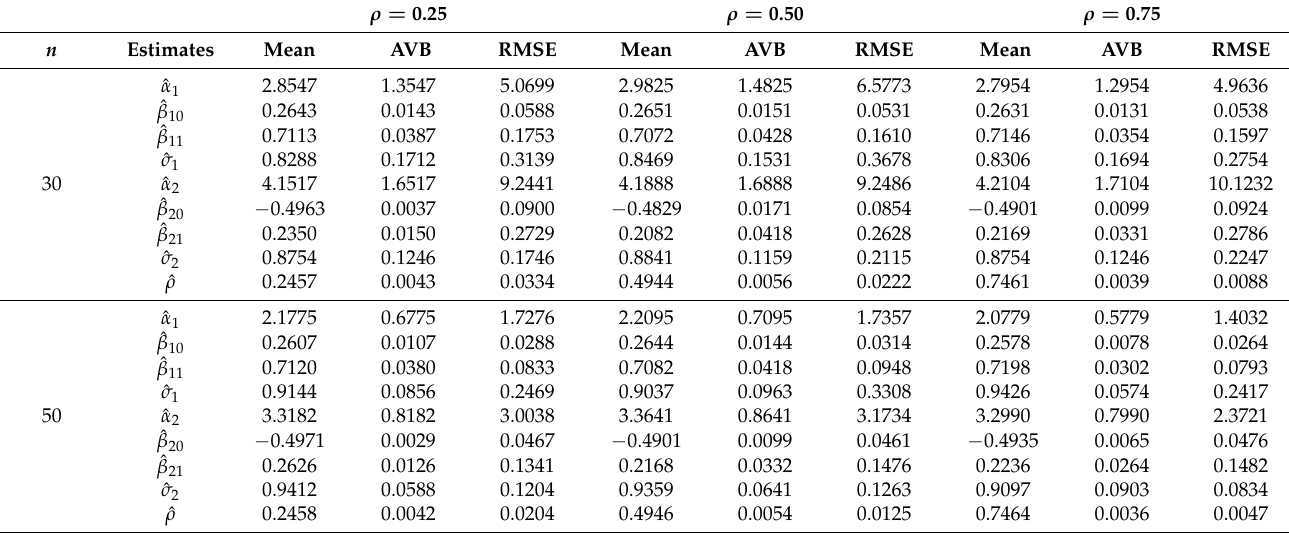
Table A1. Asymptotic behavior of the MLE for the BVSHN regression model with parameter